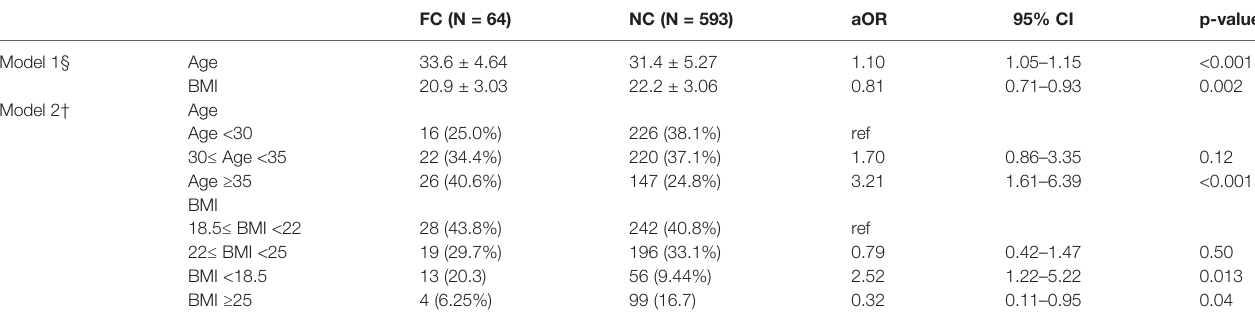
TABLE 2 | Multivariate regression models analyzed the factors associated with the incidence of functional ovarian